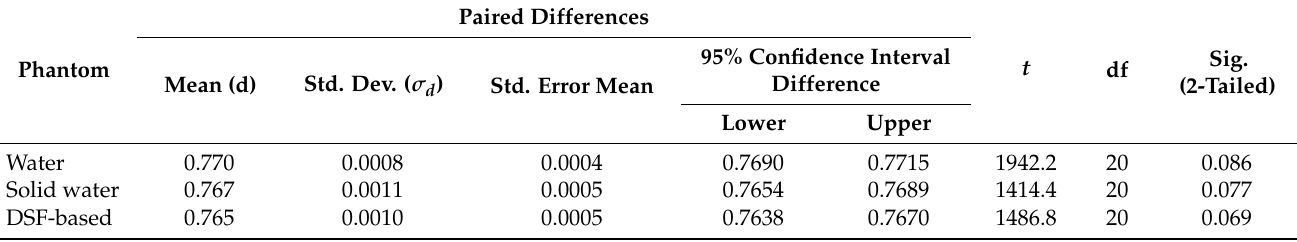
Table 9. Paired t -test of the TPR 20,10 measurement for 10 MV